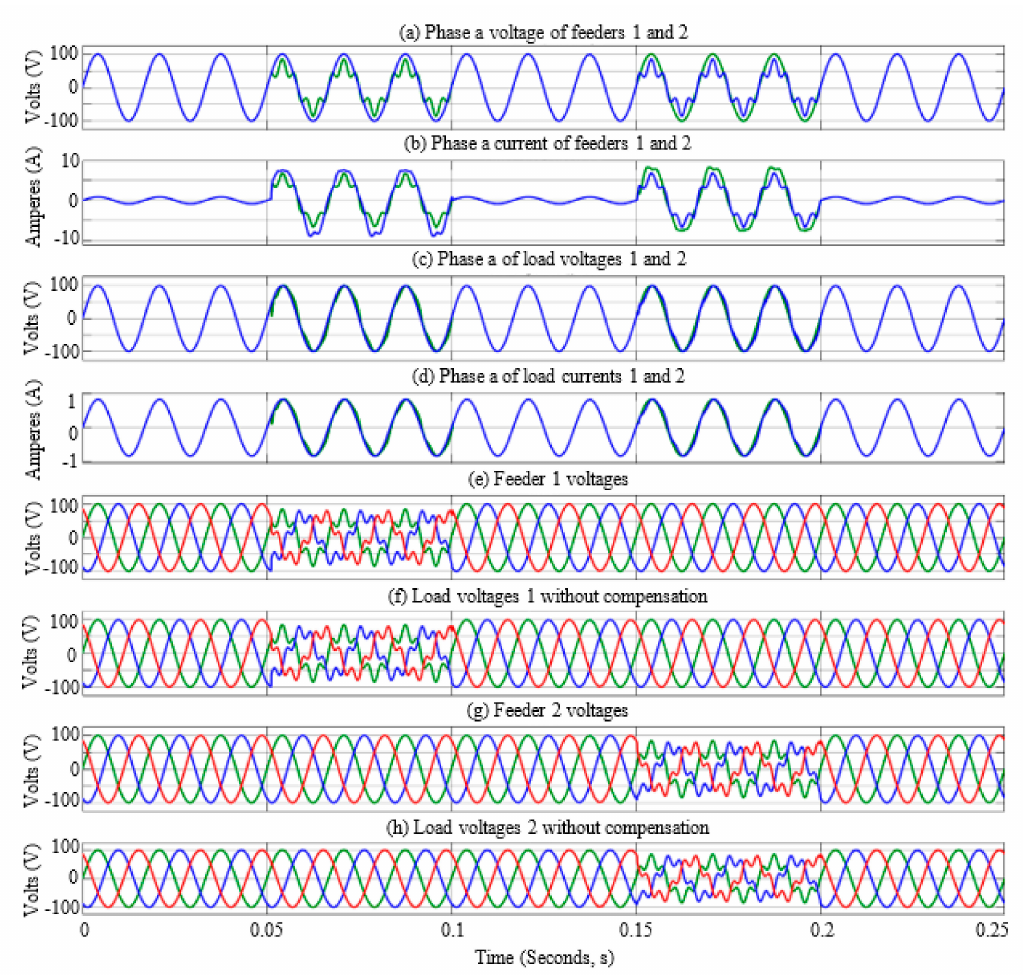
Figure 12. System waveforms in the compensation of voltage sags and harmonic distortion. ( a – d ) System waveforms (phase a ); ( e – h ) system waveforms without